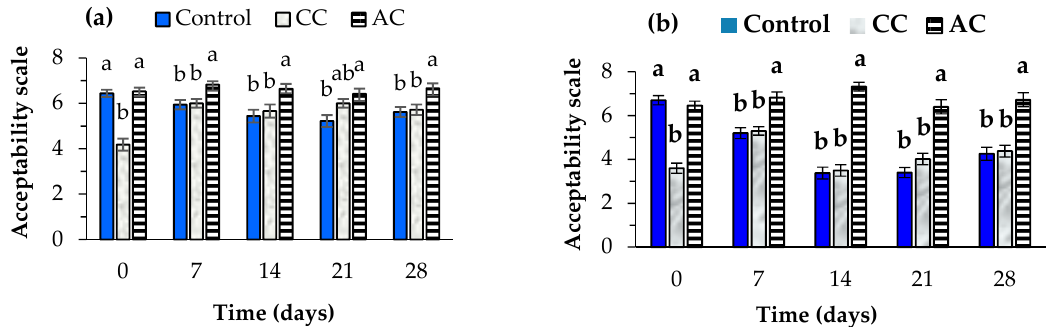
Figure 3. Effect of active coating containing microencapsulated MOEO and BEO on color ( a ) and odor ( b ) aceptability of fresh pork meat stored at 4 °C.